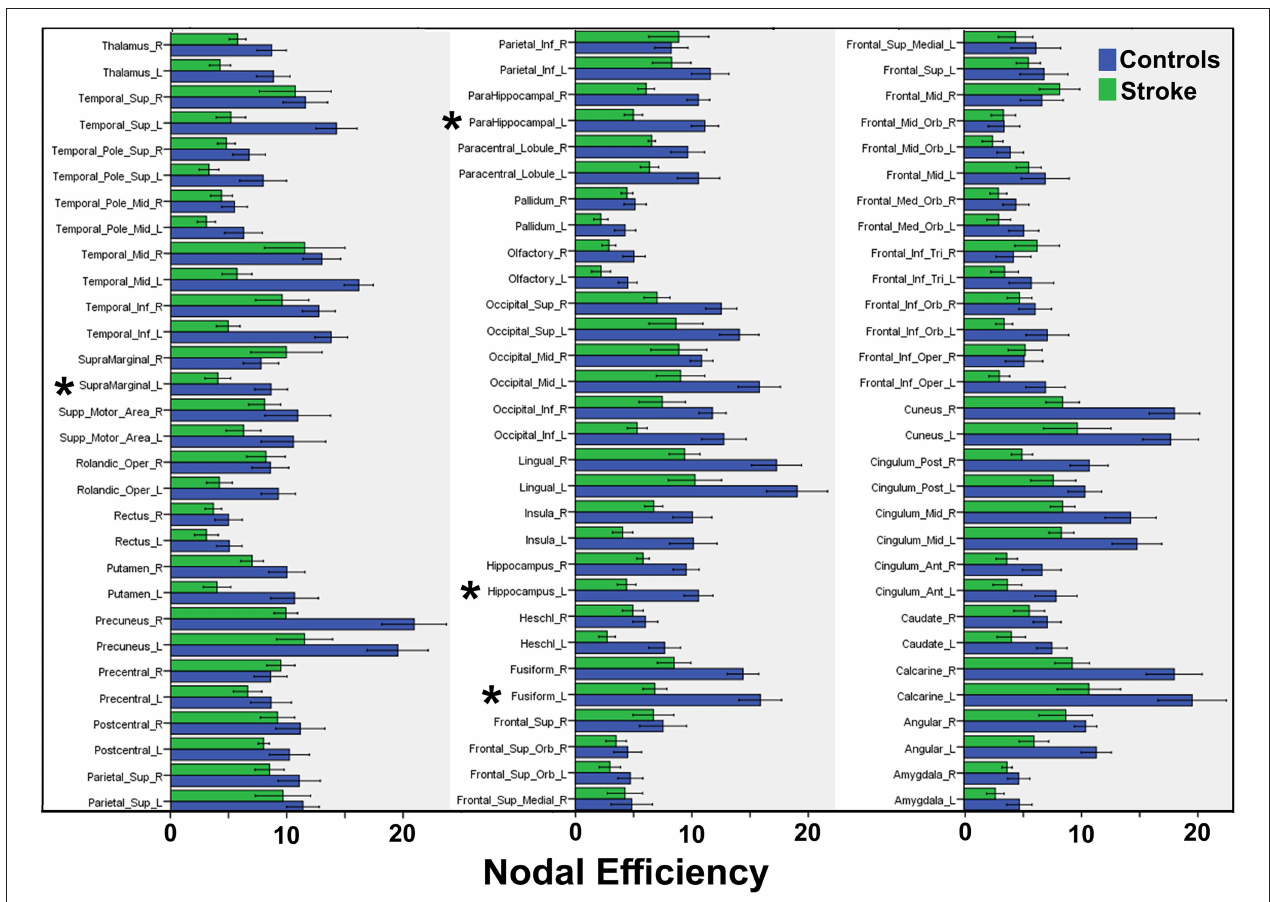
FIGURE 4 | Summary of mean nodal efficiencies. Mean efficiency values are compared between CSP (“Stroke”, green bars) and HC (“Control”, blue bars) groups for 90 AAL regions. Asterisks indicate significant differences, the statistical values for which are reported in Table 3